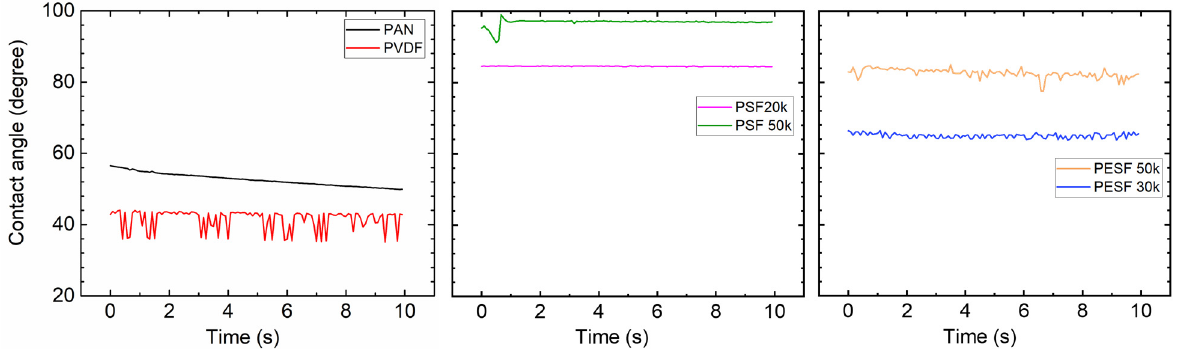
Figure 5. Contact angle of the 6 porous supports selected.